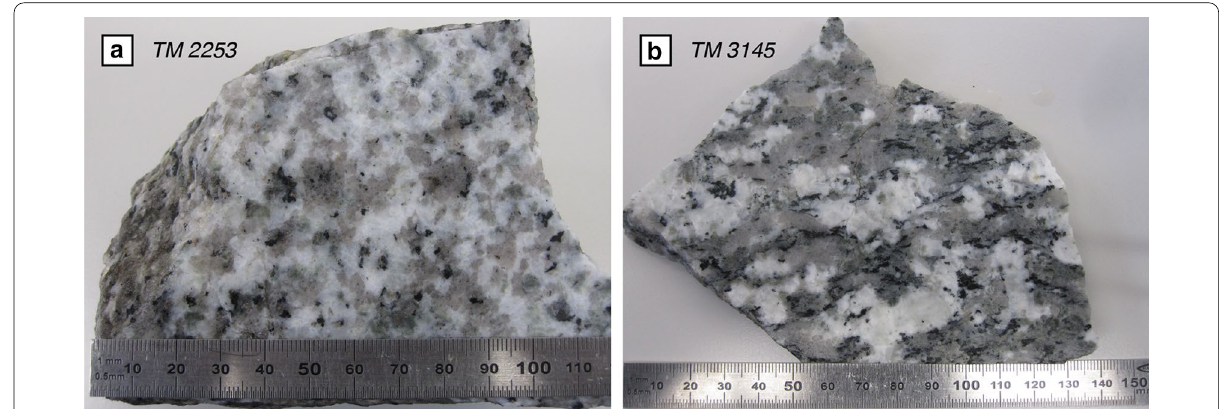
Fig. 6 Photographs of cut and wetted hand specimens taken from the Rotondo granite with macroscopically recognizable quartz (light reddish gray), plagioclase (light greenish), alkali feldspar (white), and biotite (black). a Equigranular variety (RG1). b Porphyritic variety